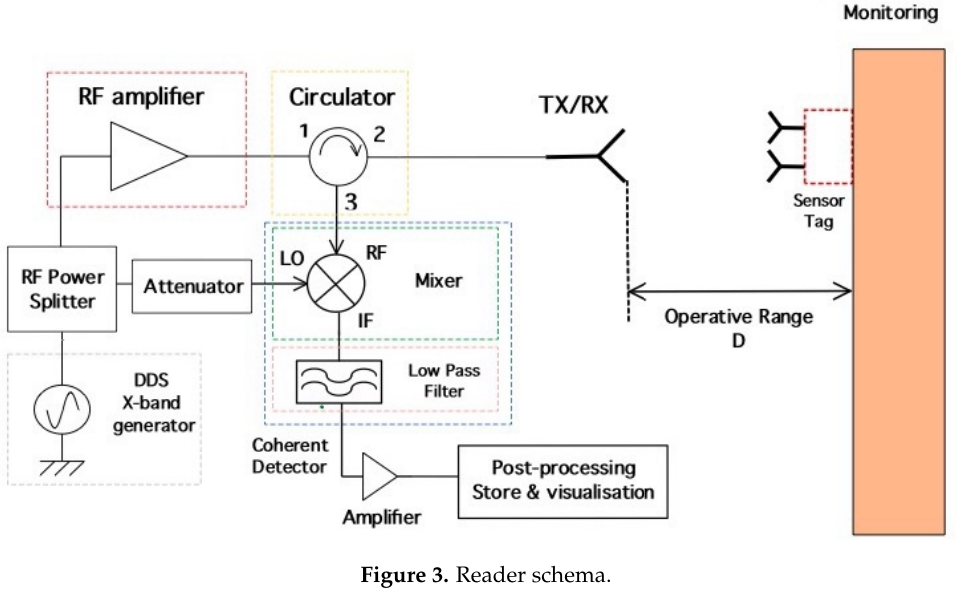
Figure 3. Reader